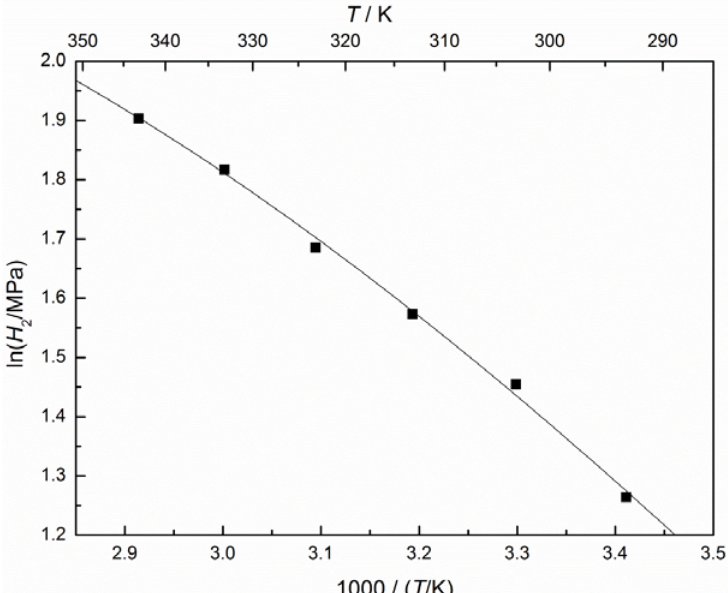
Figure 4. Henry’s constants for CO mole fraction scale as a function of the inverse temperature: ■ , extrapolated experimental values; –, correlation